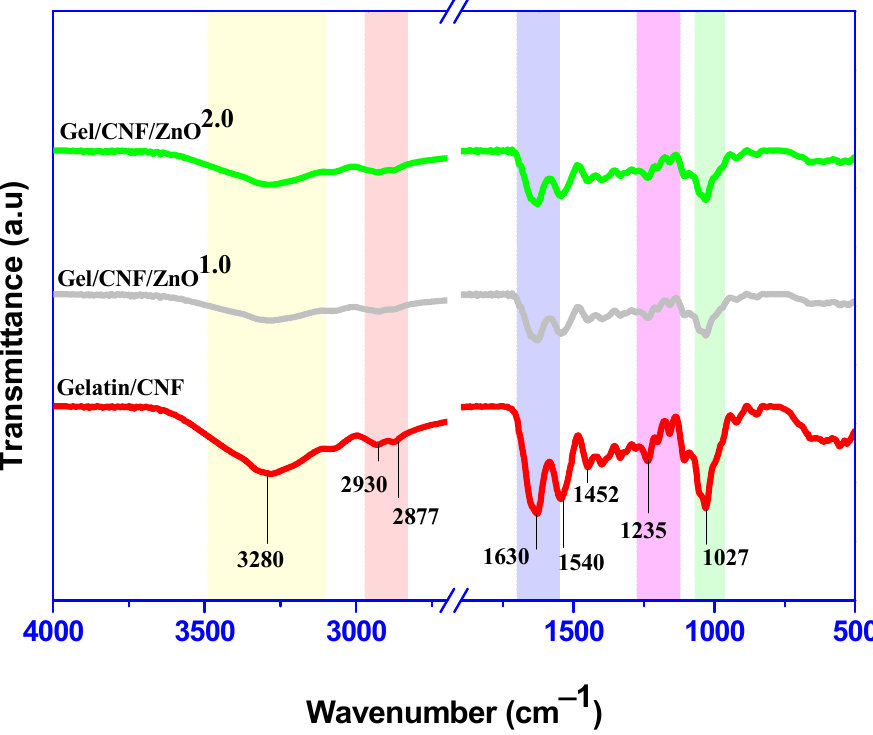
Figure 3. FTIR spectra of the gelatin/CNF ‐ based films.